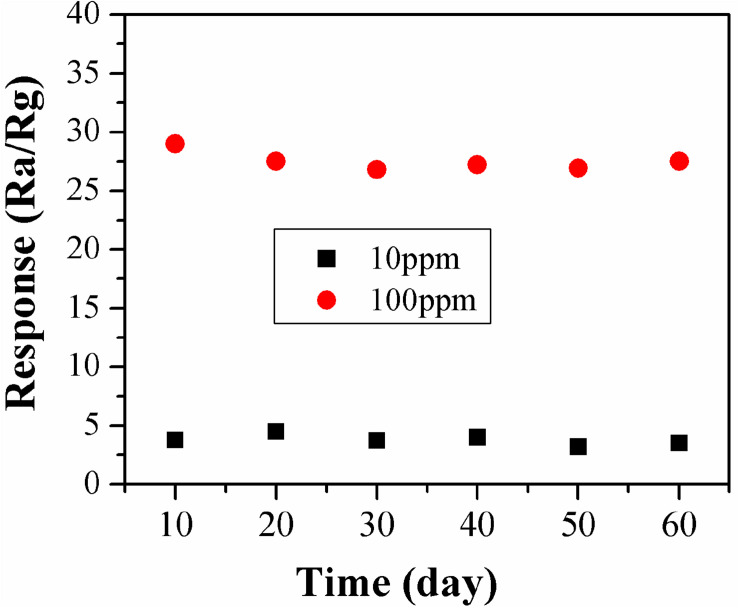
Responses of α-Fe2O3 sensor to TMA gas (10 and 100 ppm) over 60 days.